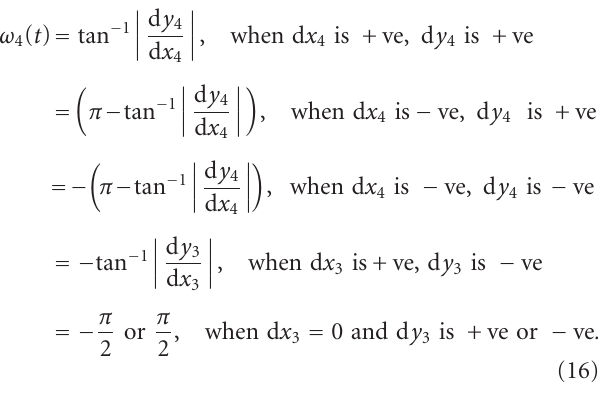
Figure 5: Straight line motion of formation of four agents with leader-follower